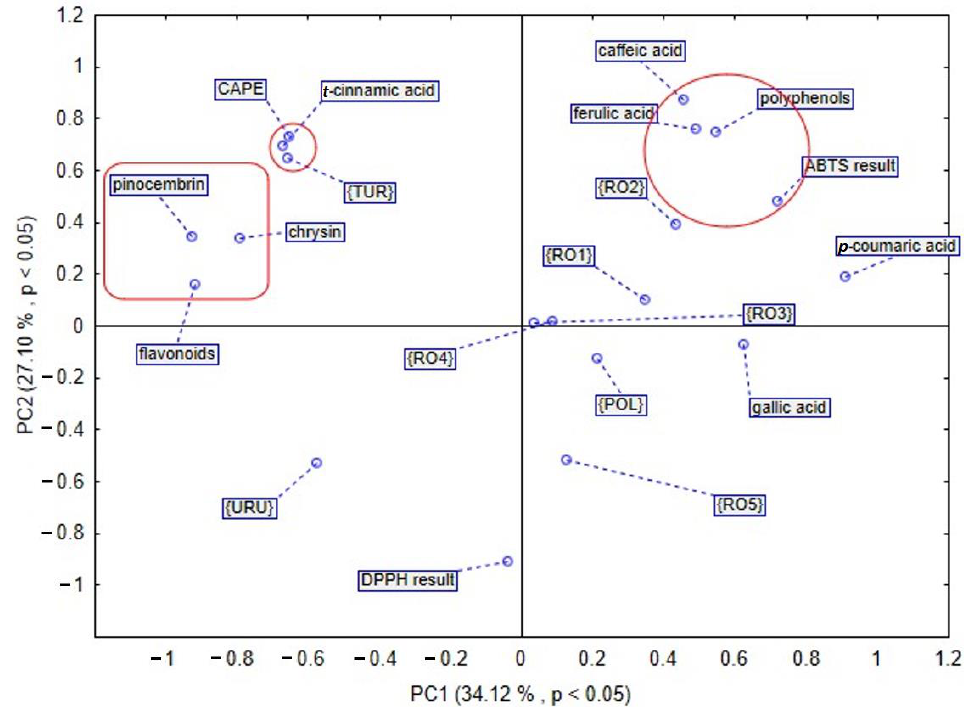
Figure 5. PCA score plot obtained by analysis of bioactive compounds identified in tested propolis samples. This PCA was based on analysis of detected bioactive compounds derived from different propolis samples.